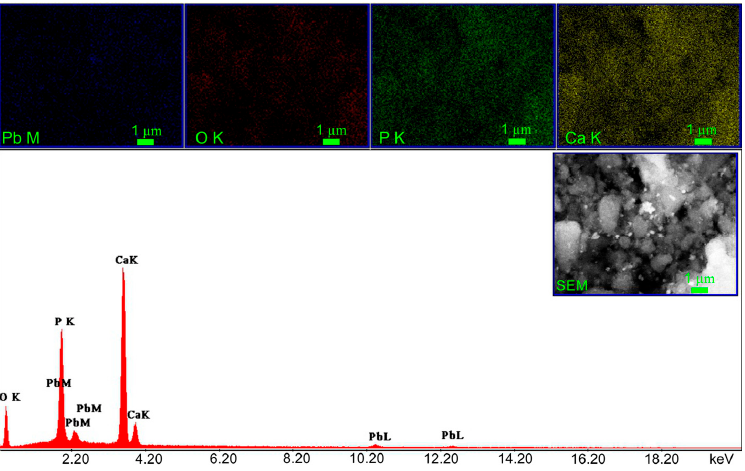
Figure 12. EDX spectrum and elemental mapping of CD-HAp_1 sample after the adsorption of Pb 2+ .